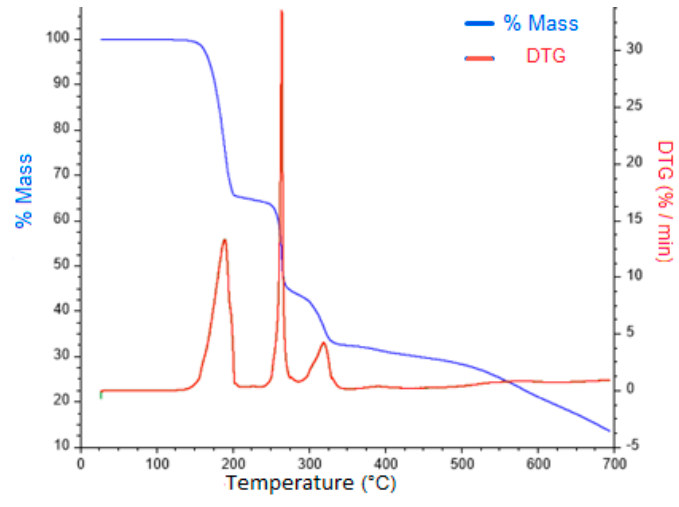
Figure 2. TGA and DTG for complex 4 .